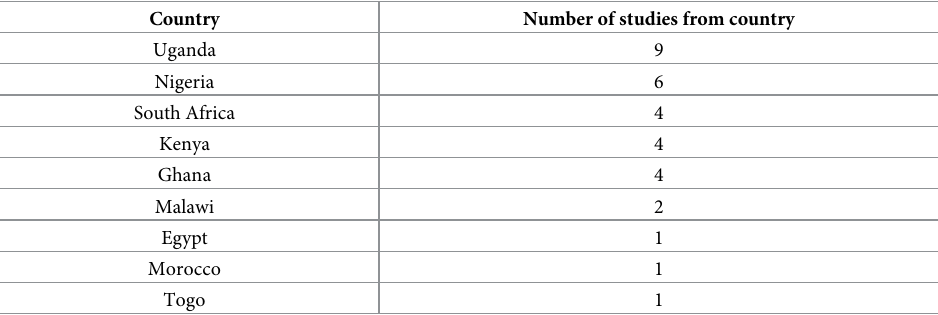
Table 2. Country representation of included studies (studies conducted in multiple countries were counted for each).